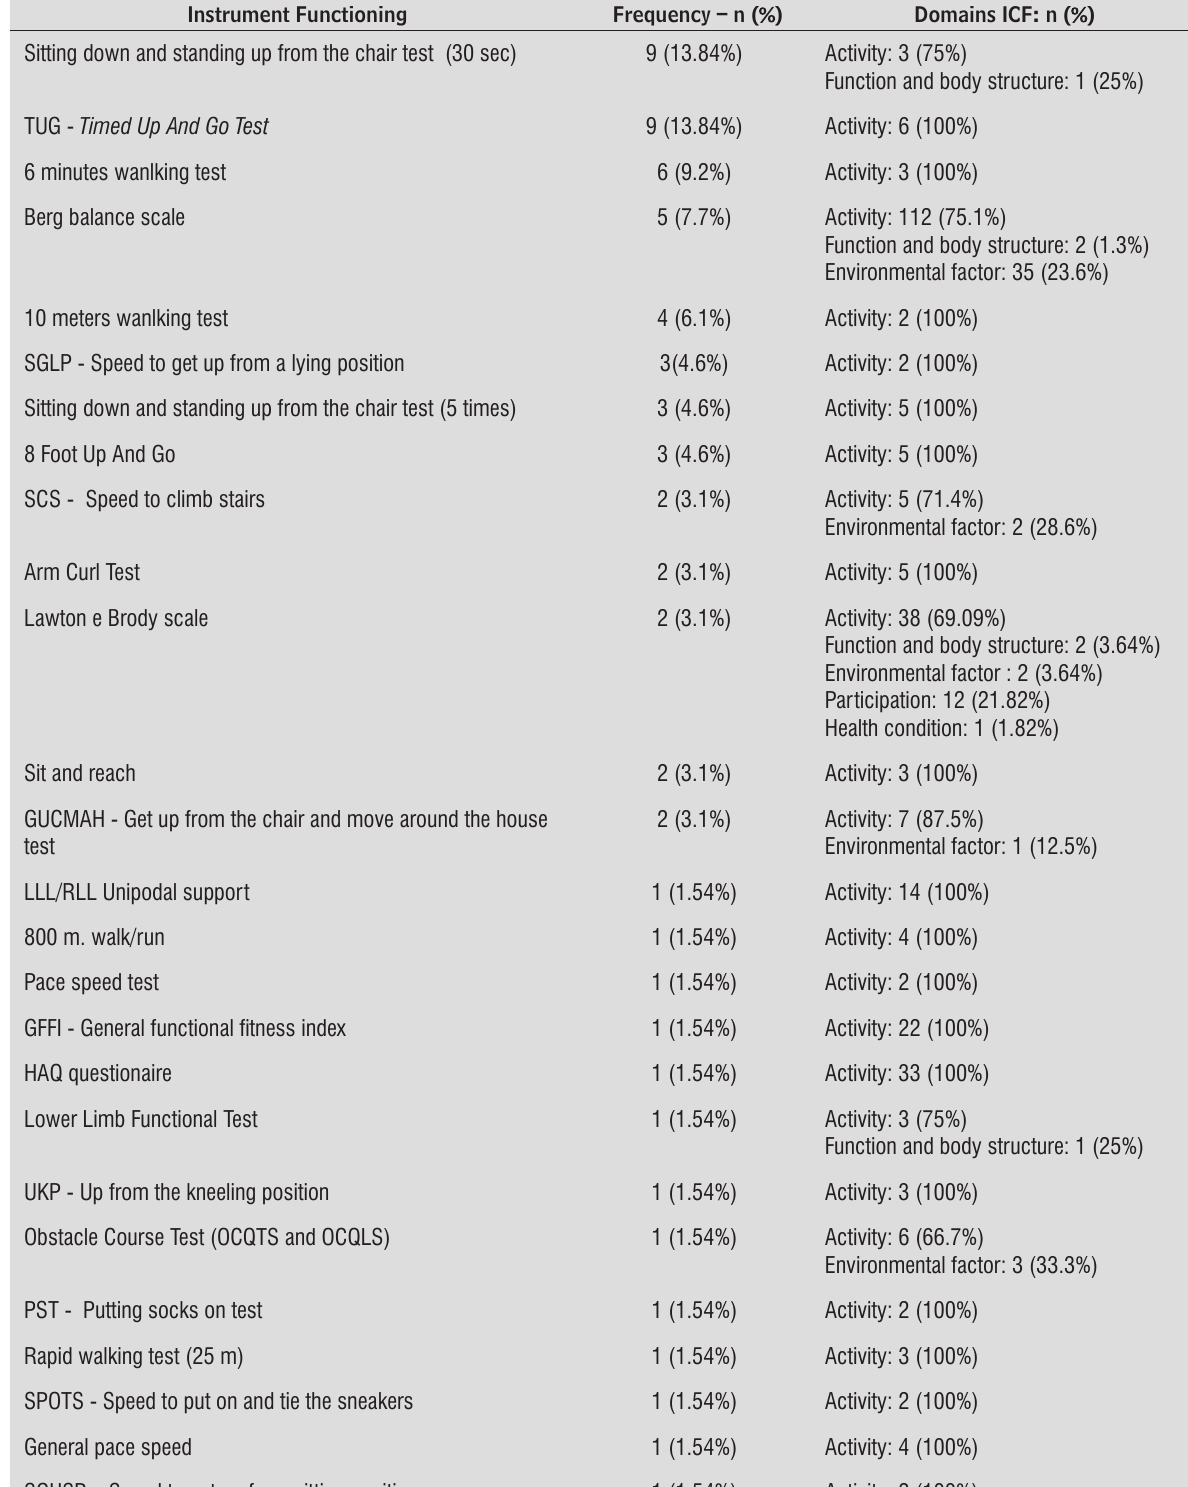
Table 2 - Frequency distribution of the instruments included and of the domains of the International Classification of Functioning and Health (ICF) contained in each Instrument Functioning